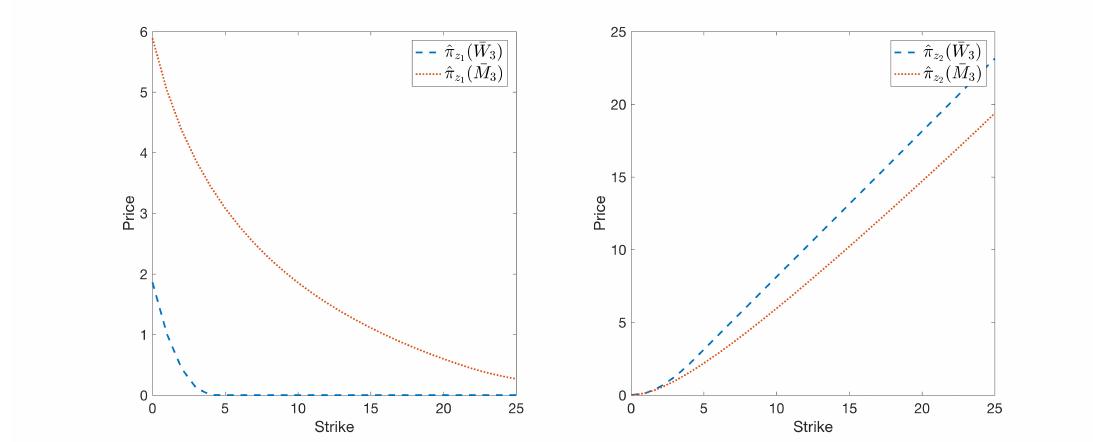
Figure 1: Bounds for Π ( Z 1 ) (left) and Π ( Z 2 ) (right) derived by the Fréchet–Hoeffding bounds as a function of the strike; Setting 1.